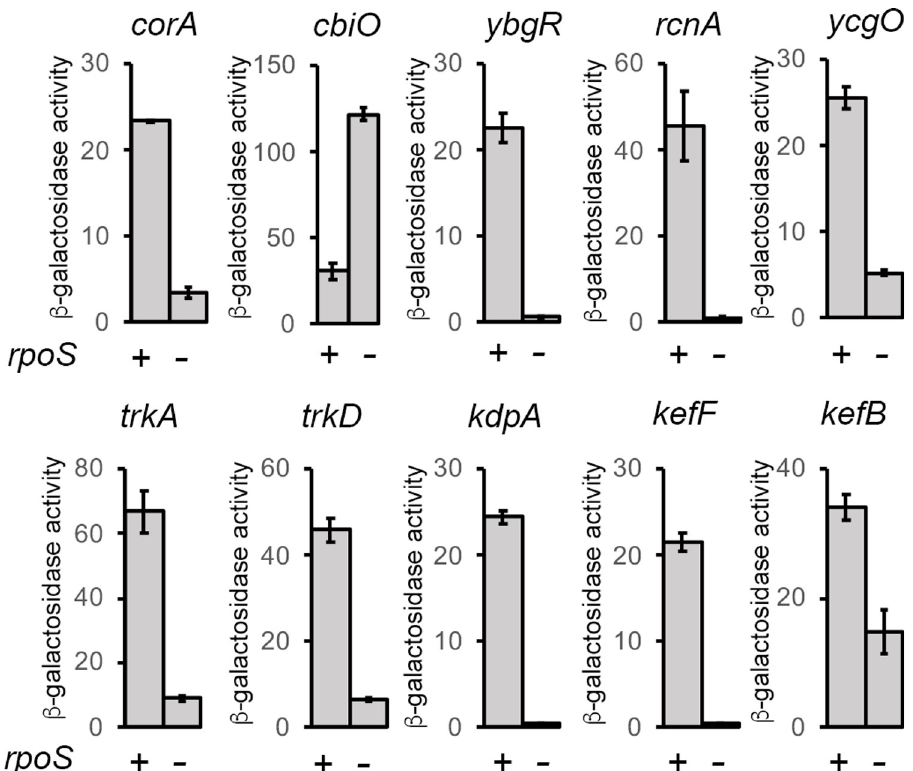
Fig 6. Expression of lacZ fusions in genes involved in magnesium, cobalt and potassium trafficking. Expression of lacZ fusions in genes encoding potassium transport (TrkA, TrkD, KdpA) and efflux (KefCF, KefB) systems, the potassium/proton antiporter YcgO, the magnesium transporter CorA and proteins involved in cobalt import (CbiO) and efflux (RcnA, YbgR) was assessed in the wild type and Δ rpoS strains grown for 18 h in LB at 37˚C. Bar graphs represent the mean β -galactosidase activity, and error bars represent standard error of the mean of at least three independent experiments. The effect of the Δ rpoS mutation was significant in all cases (p < 0.001).